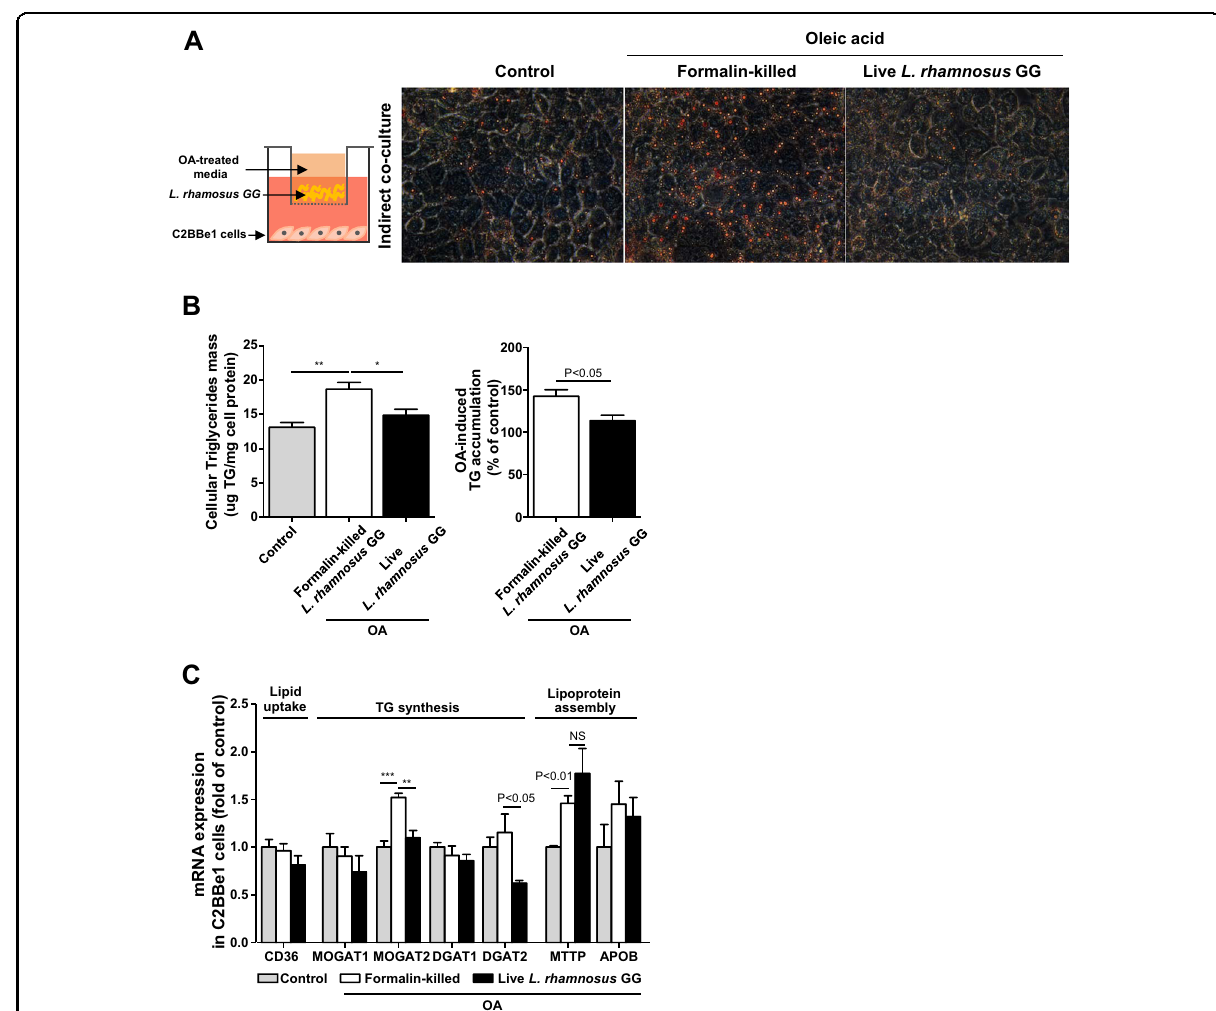
Fig. 2 Lactobacillus rhamnosus GG reduces oleic acid-induced intestinal fat accumulation in vitro. a Oil Red O staining of OA-induced lipid accumulation in C2BBe1 cells cocultured indirectly with L. rhamnosus GG (original magni fi cation ×40). b Cellular TG mass and OA-induced TG accumulation by the control. c mRNA levels of genes related to intestinal lipid metabolism in C2BBe1 cells. Data are expressed as the mean ± SEM from three independent experiments. * P < 0.05, ** P < 0.01, and *** P < 0.001 by one-way ANOVA with post hoc analysis. Statistical comparisons obtained by Student ’ s t -test. NS, nonsigni fi cant. Formalin-killed LGG, formalin-killed L. rhamnosus GG-treated C2BBe1 cells. Live LGG, live L. rhamnosus GG-treated C2BBe1